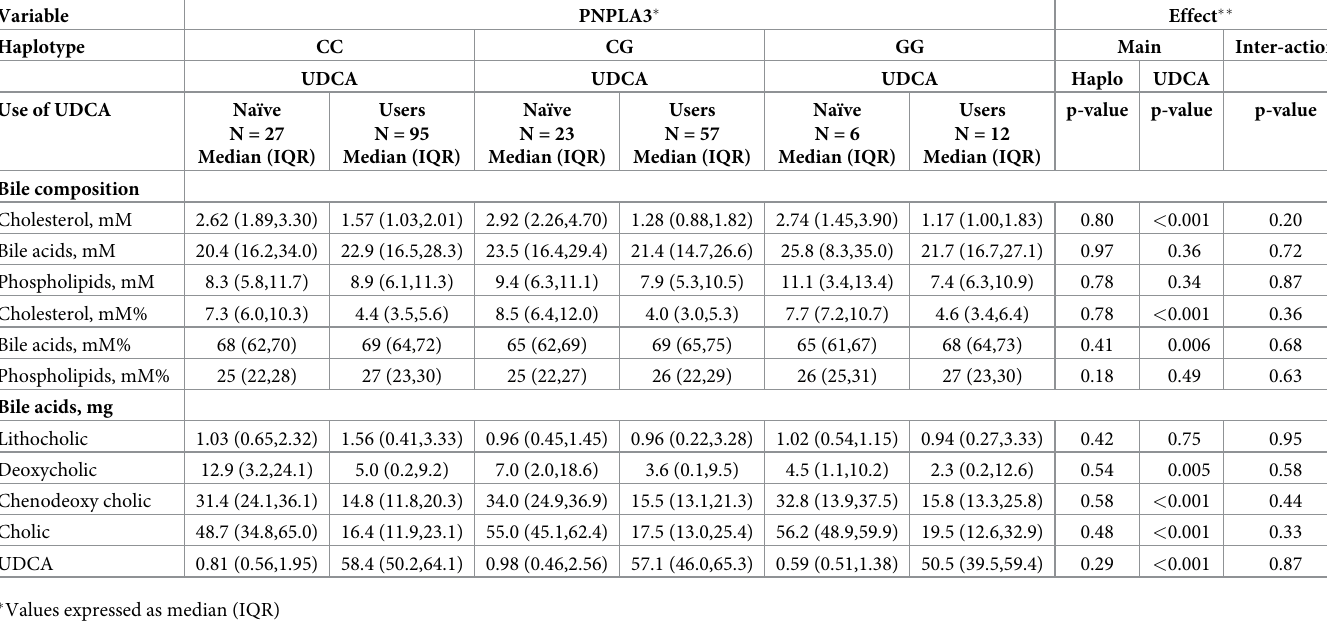
Table 3. Impact of PNPLA3 allele frequency and UDCA administration and their interaction on bile composition in PSC.